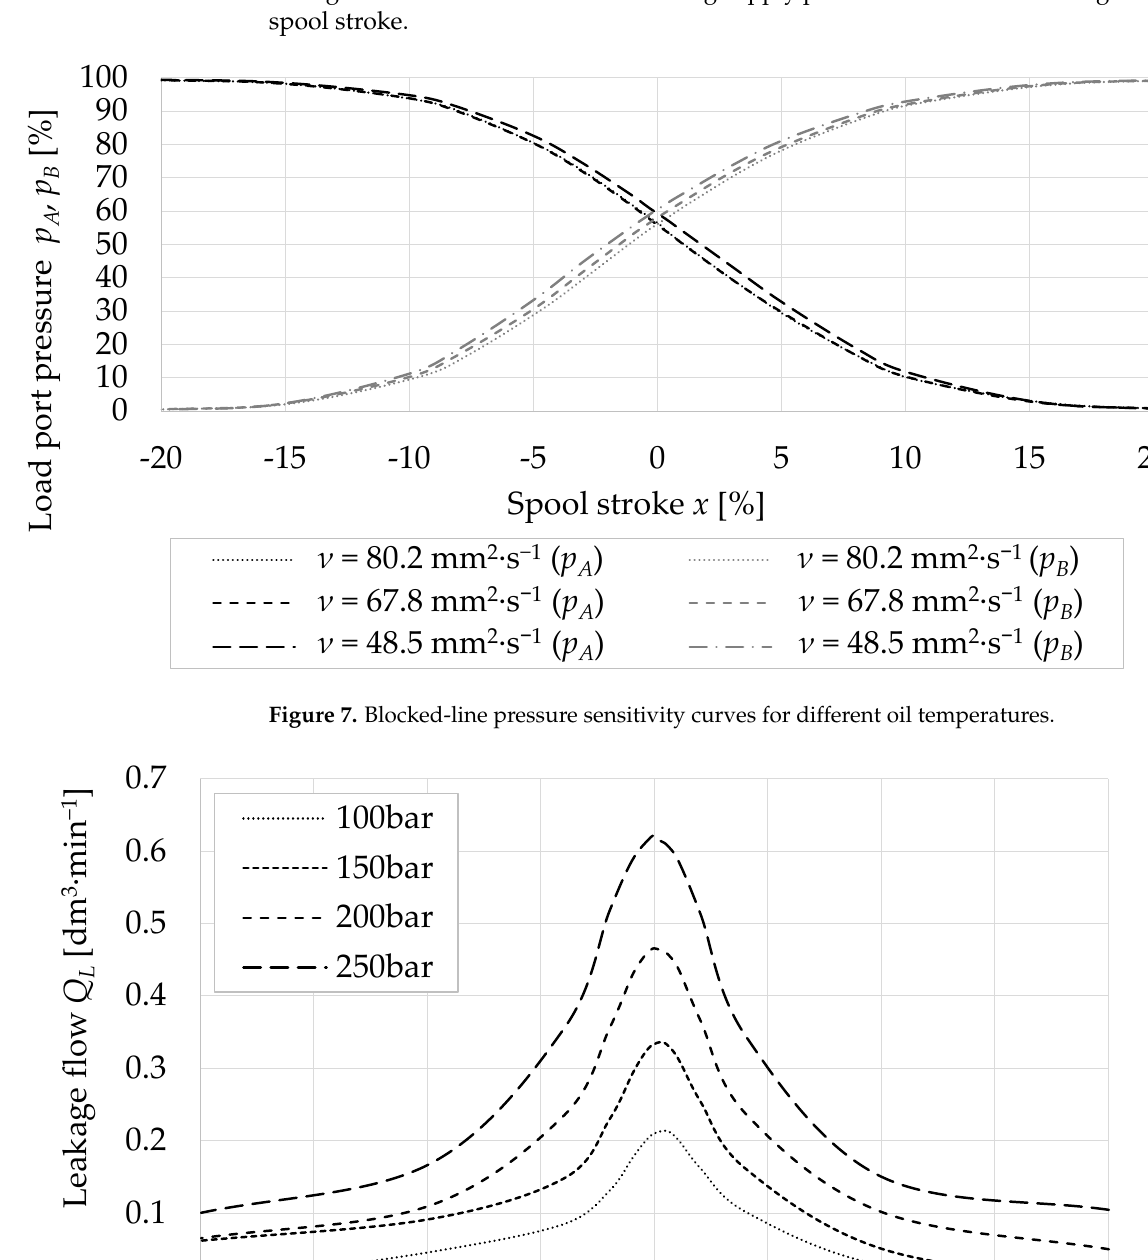
8 of 14 Figure 6. Blocked-line pressure sensitivity curves for different supply pressures.